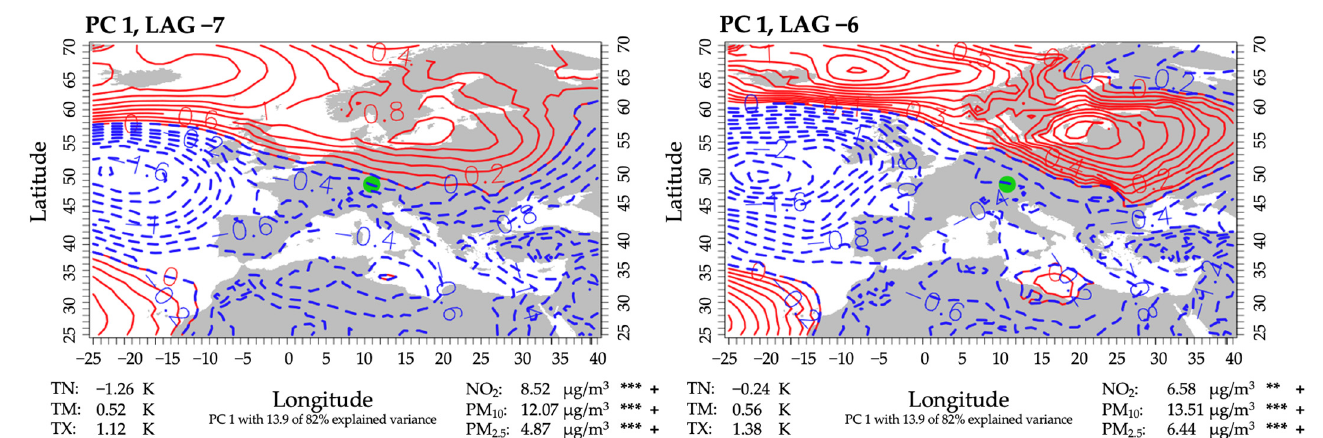
Figure 4. Weather sequence of PC 1 for lag days 9 to 6 before a high mortality event in April through June. Contours are scores of PC 1 and refer to the sea level pressure on a given day, with red indicating high pressure and blue indicating low pressure. Also given are mean predictor anomalies of all corresponding days of the same lag for air temperature and the chosen air pollutants (for abbreviations, see Table 1). Positive values indicate an above-average state, and negative values indicate a below-average state. If the values of a specific lag day deviate significantly from all non-high-mortality-related days within April through June, the level of significance is provided (***: 0.01; **: 0.05; *: 0.1; determined by U test) as well as the mean difference of all days of the same lag minus the mean of all non-high-mortality-related days, indicated by + or − . + indicates a higher anomaly mean on the corresponding lag days than on non-high-mortality-related days.